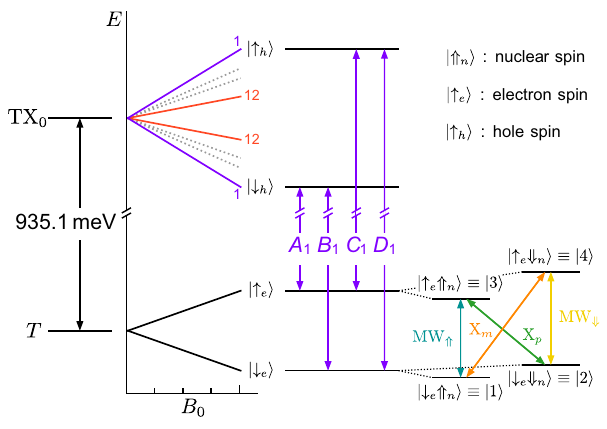
FIG. 1. Energy level diagram of the T center 935.1-meV TX 0 optical transition. Under a magnetic field, the unpaired electron spin of the paramagnetic ground state T and the unpaired hole spin of the excitonic excited state TX 0 split into doublets. The anisotropic hole spin determines 12 orientational subsets for a given magnetic field orientation, with optical transitions A i – D i for subset i , that may be optically resolved. The nuclear spin transitions are resolvable with microwave addressing.